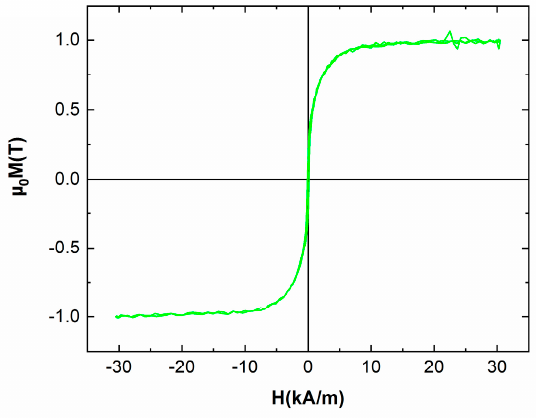
Figure 7. 300 K hysteresis loop for the as-cast sample.